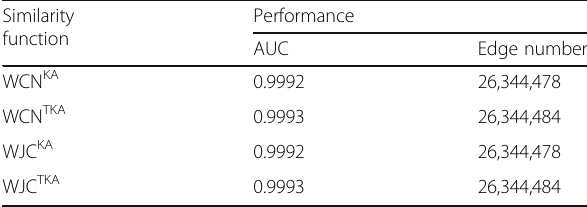
Table 5 The result of performance metrics in the different functions Similarity